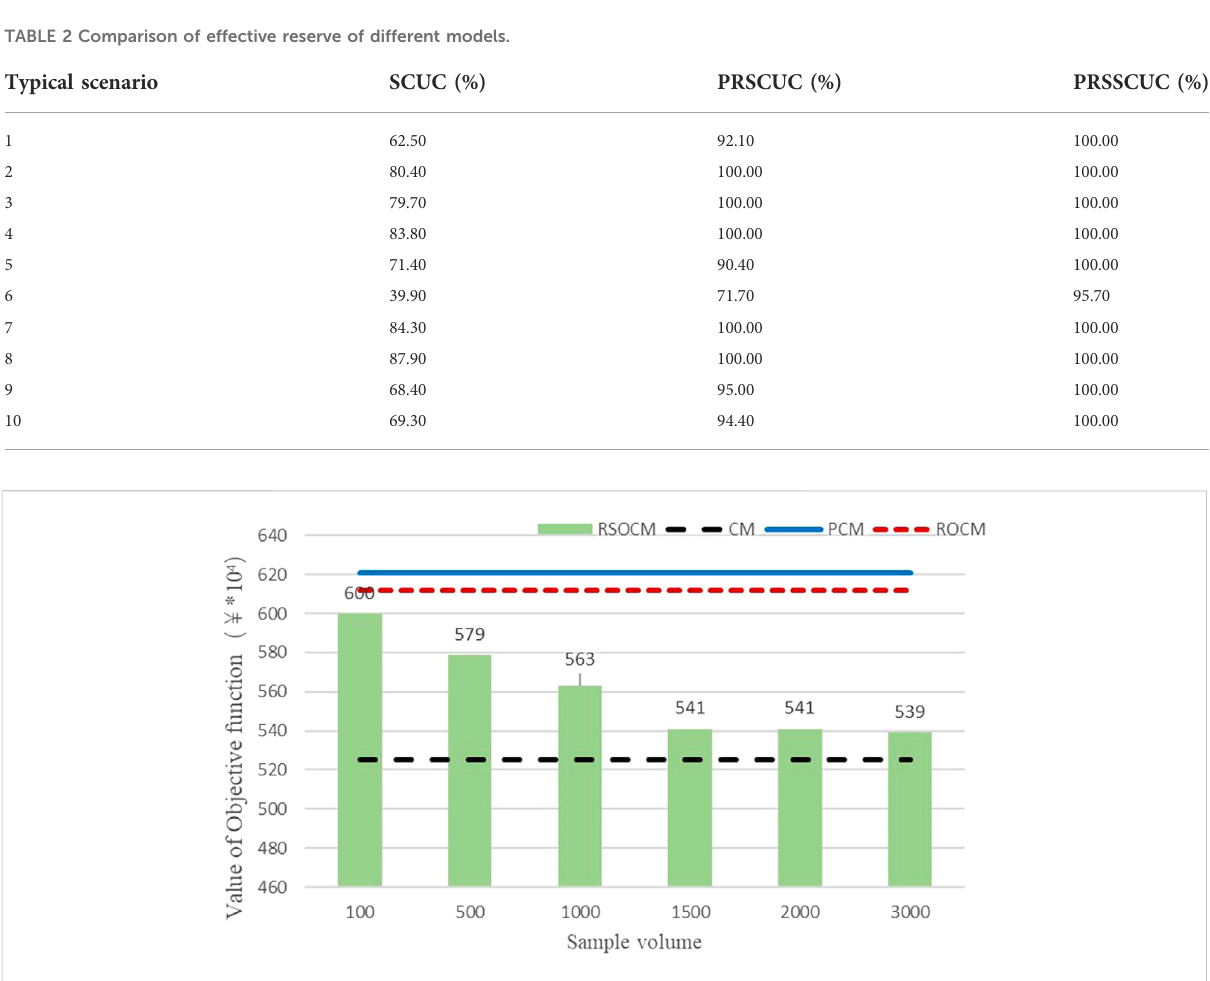
FIGURE 3 Comparison of objective functions of different models under different sample volumes.